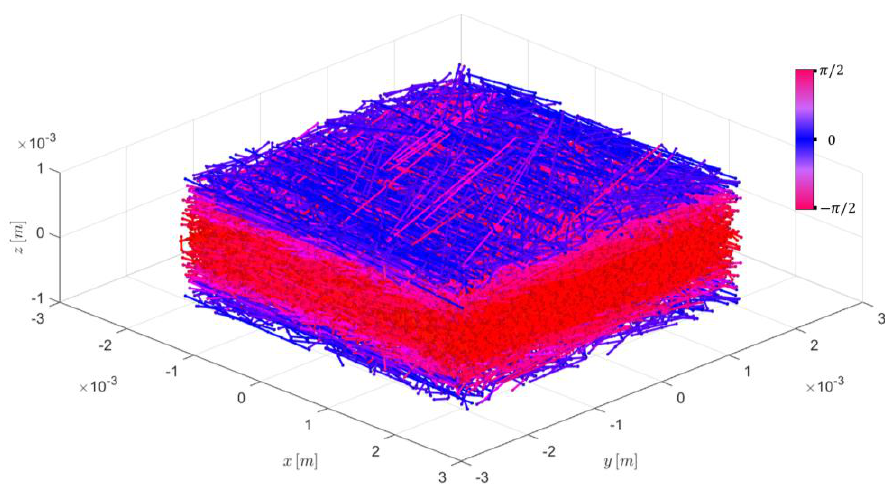
Figure 7. Computational compression molded cluster, with x as the shearing direction (a 11 ). Fibers are colored as a function of their XY ( = 12) planar orientation [43].